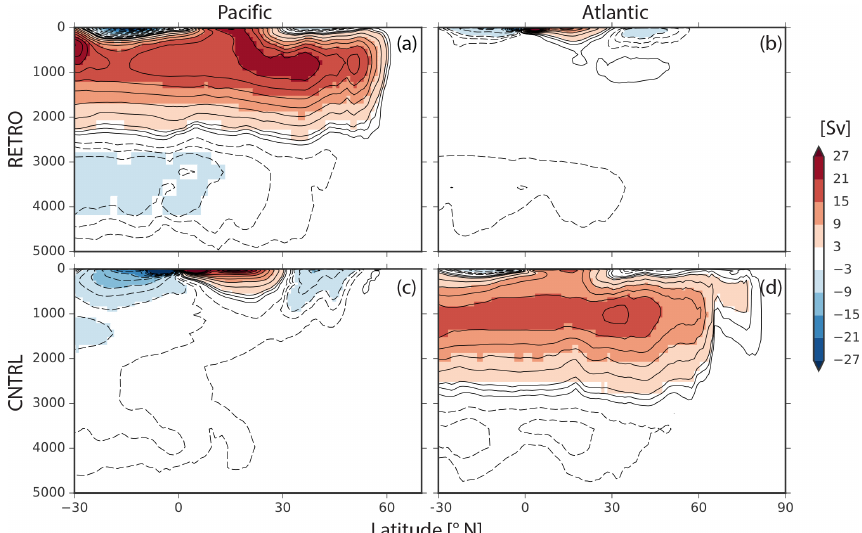
Figure 13. MOC stream functions. Outlines are at ± 1,2, and multiples of 3Sv. The Indian Ocean MOC stream functions are shown in Fig. 17.